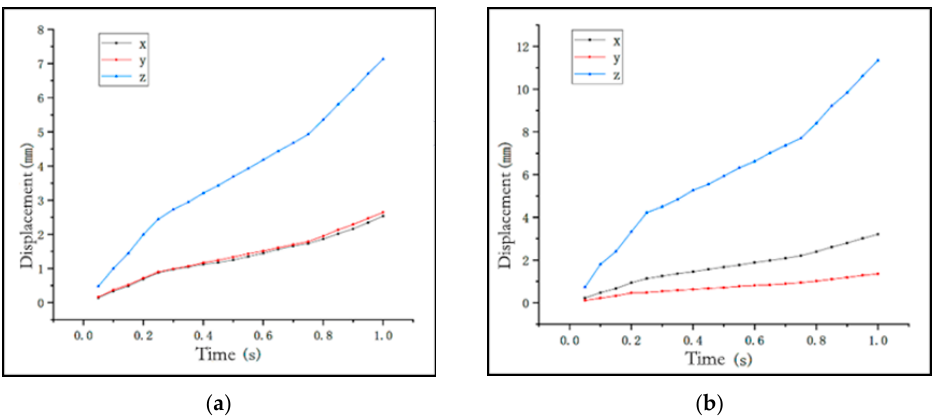
Figure 10. Print platform transient analysis curve. ( a ) The moving displacement of the platform driven by a single branch; ( b ) The moving displacement of the platform driven by a multiple branches.